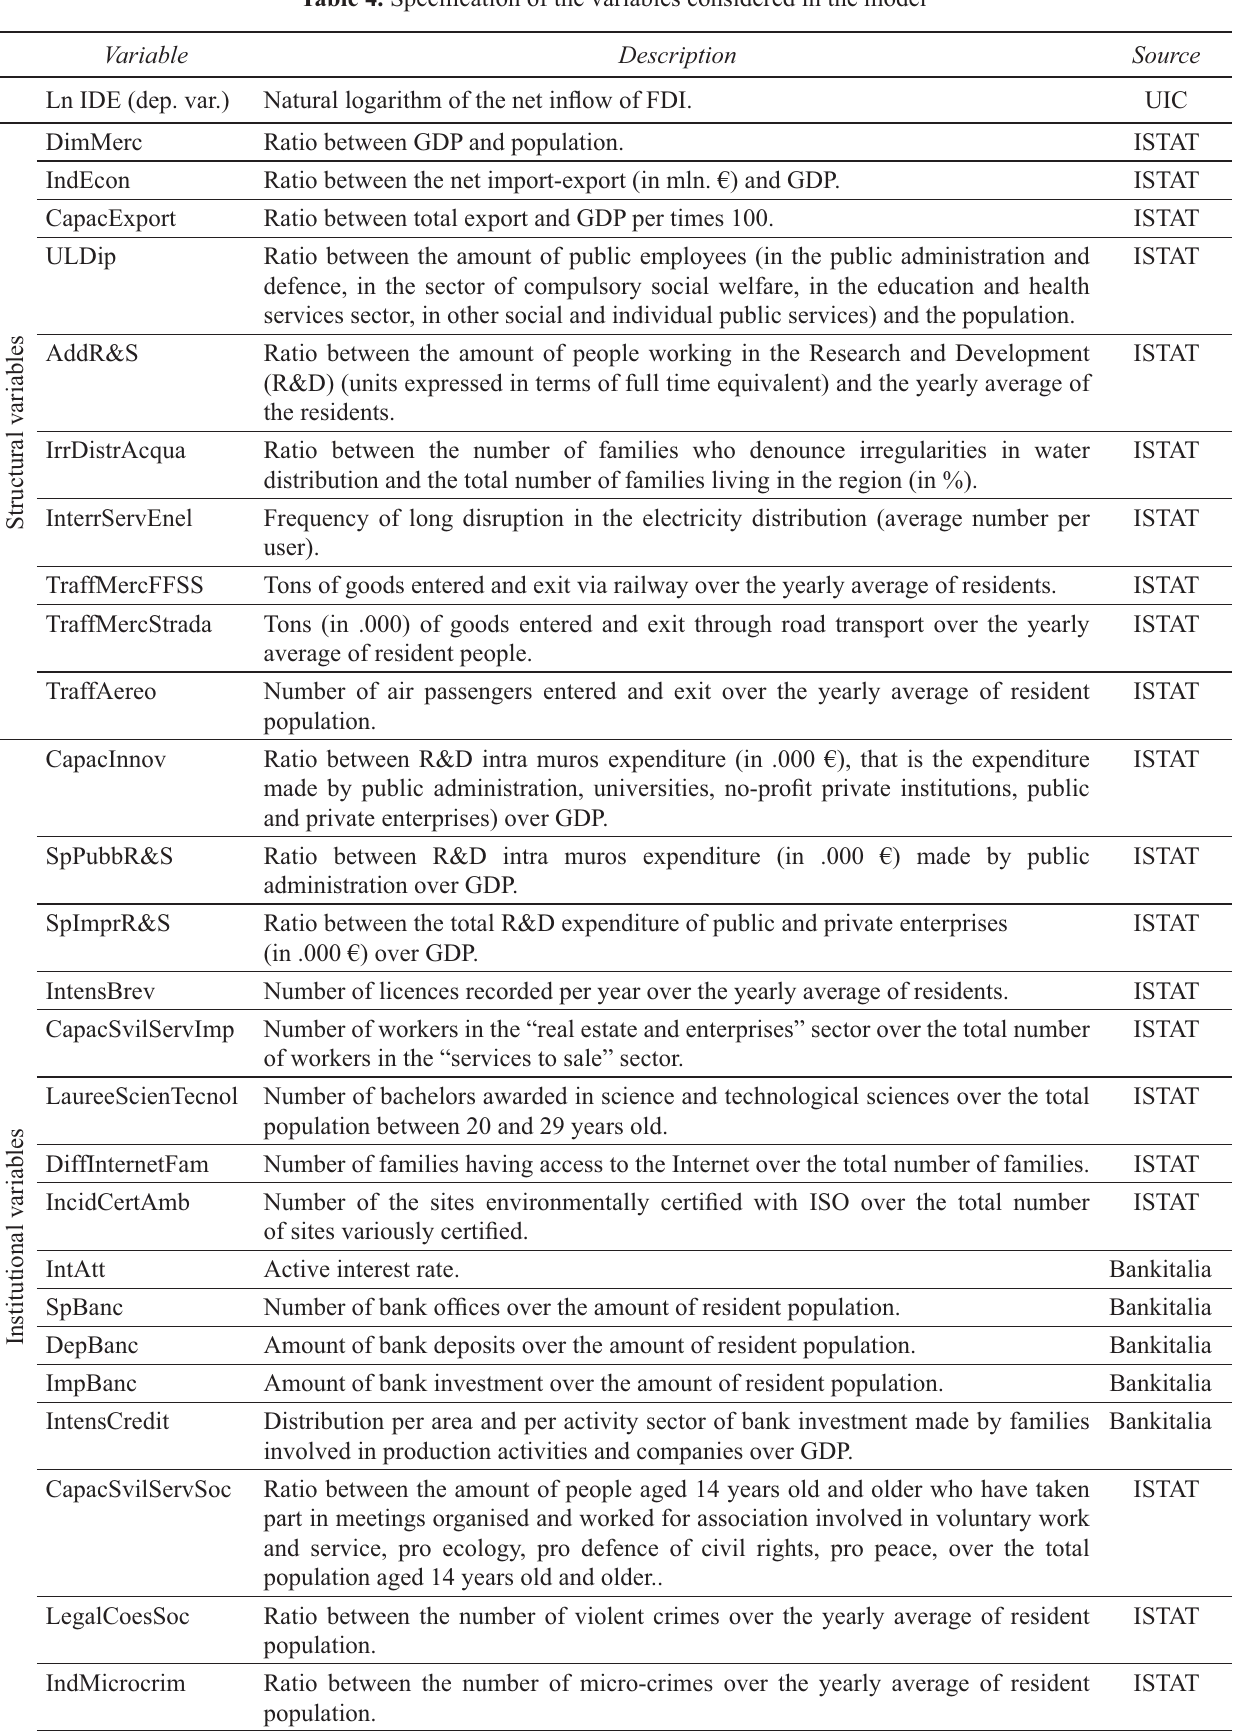
Table 4. Specifi cation of the variables considered in the model Variable Description